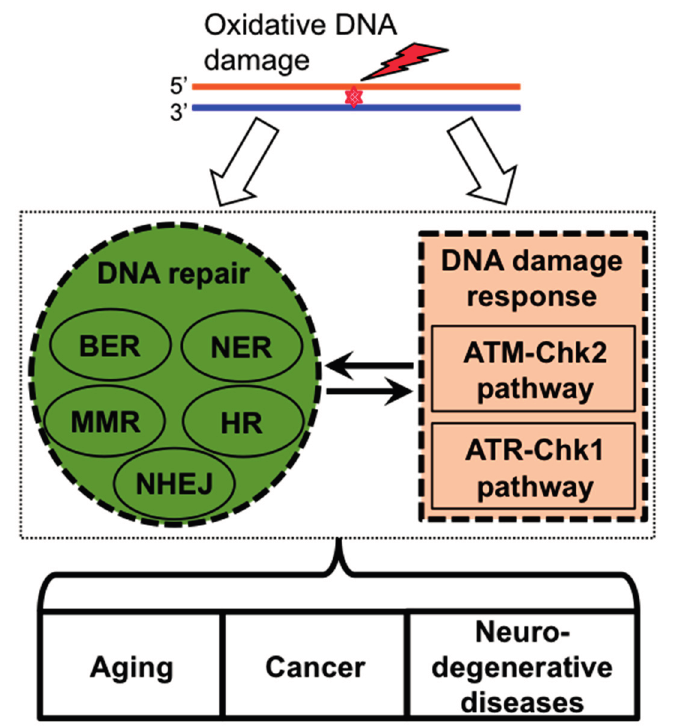
Figure 1. Cellular responses to oxidative DNA damage. DNA repair pathways (BER, NER, MMR, HR, and NHEJ) and DNA damage response pathways (ATM-Chk2 and ATR-Chk1) are integrating into an interacting network in response to